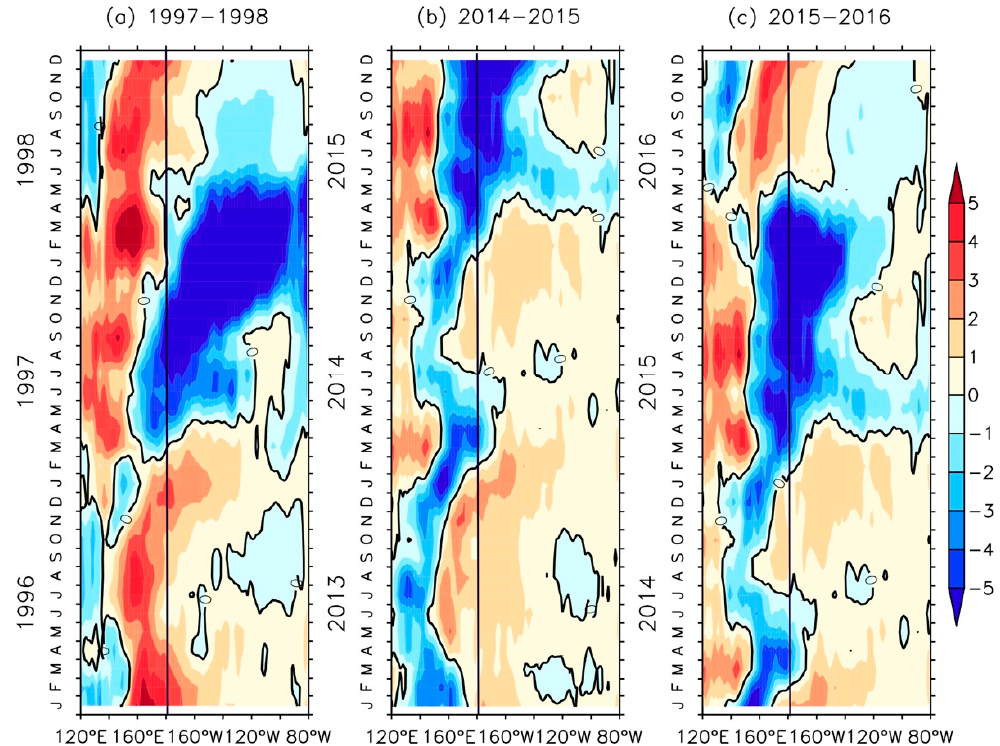
Figure 9. Longitude–time sections of FWF anomaly along the equator (averaging over 2 ◦ S–2 ◦ N) during ENs for ( a ) 1997–1998, ( b ) 2014–2015, and ( c ) 2015–2016. The vertical black line represents the location of the international the dateline. The units for FWF are mm /